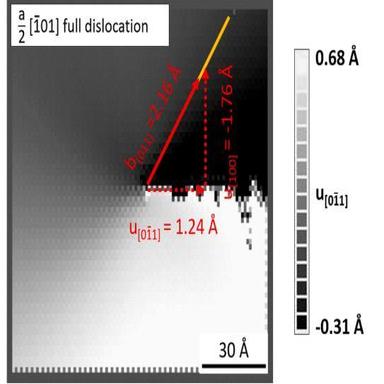
Burgers vector projection obtained by vectorial evaluation of displacement vectors and site of the simulated dislocation plane (orange line) of the a 2 full dislocation.